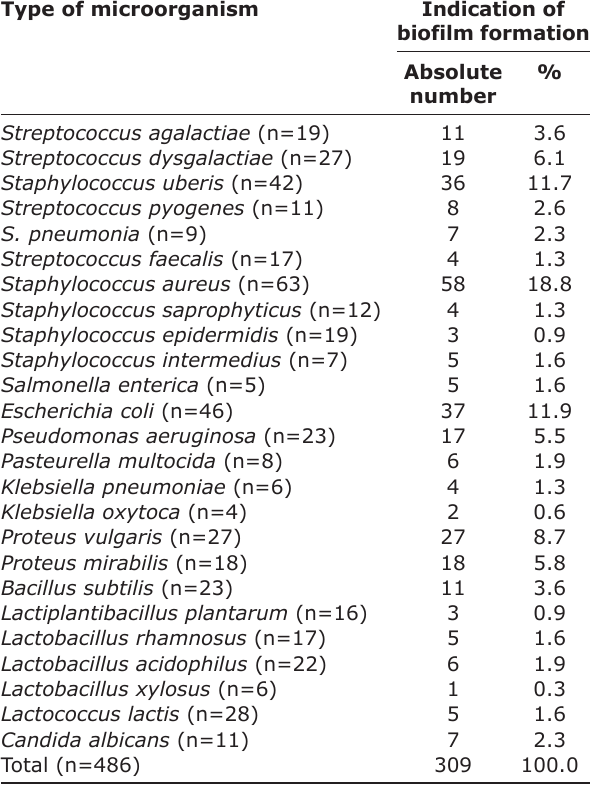
Table-6: Assessment of the ability of milk isolates from cows with mastitis to biofilm formation.